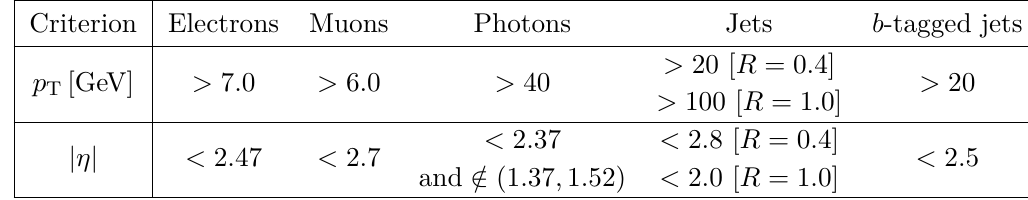
Table 5 . Summary of preselection criteria in ATLAS-CONF-2020-002, reproduced in part from section 4 of [1].